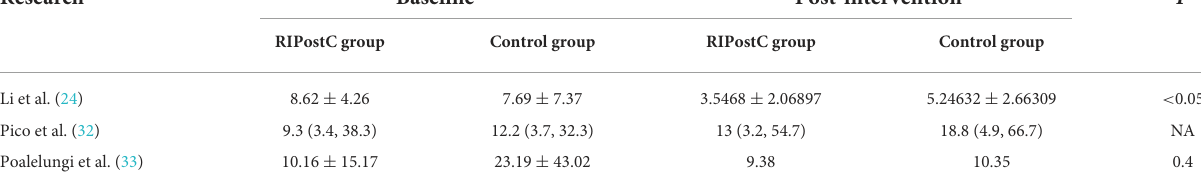
FIGURE8 Forest plot showing security with RIPostC.